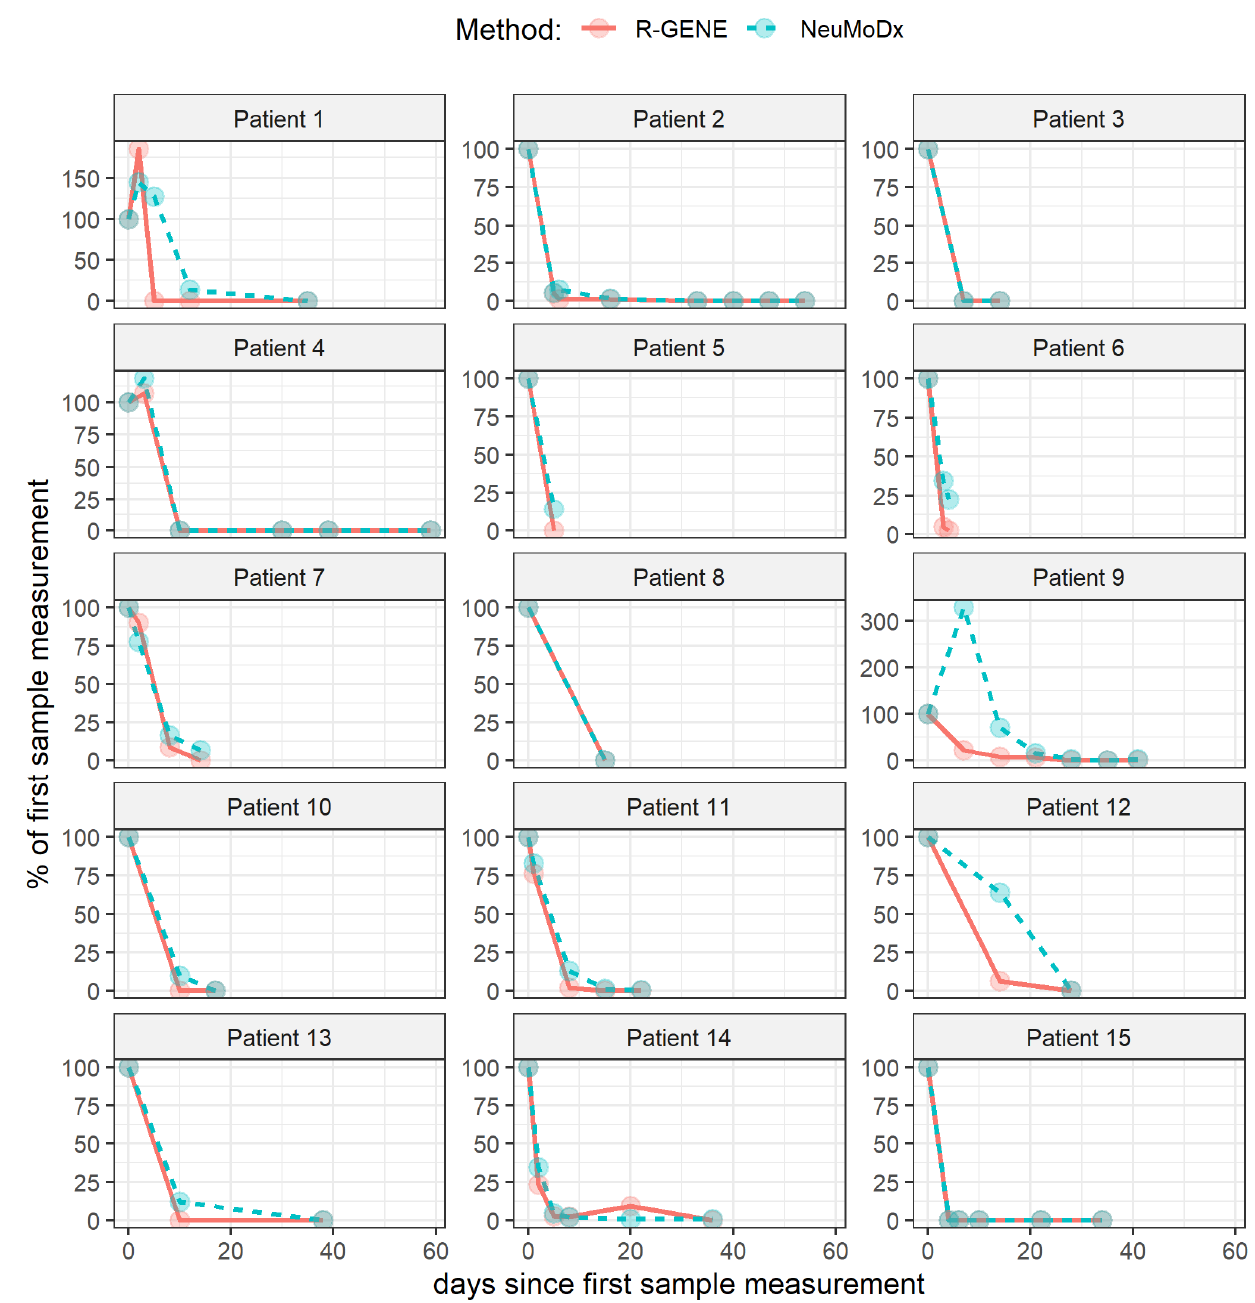
Figure 2. Evolution of CMV viral load kinetics for 15 solid organ recipient patients presented with CMV reactivation during our study. Data obtained from the two techniques were converted as a percentage of the initial measured viral load (%CMV 0 ). All patients received anti-CMV treatment from D0, except for patient 9, whose treatment was initiated at D7.